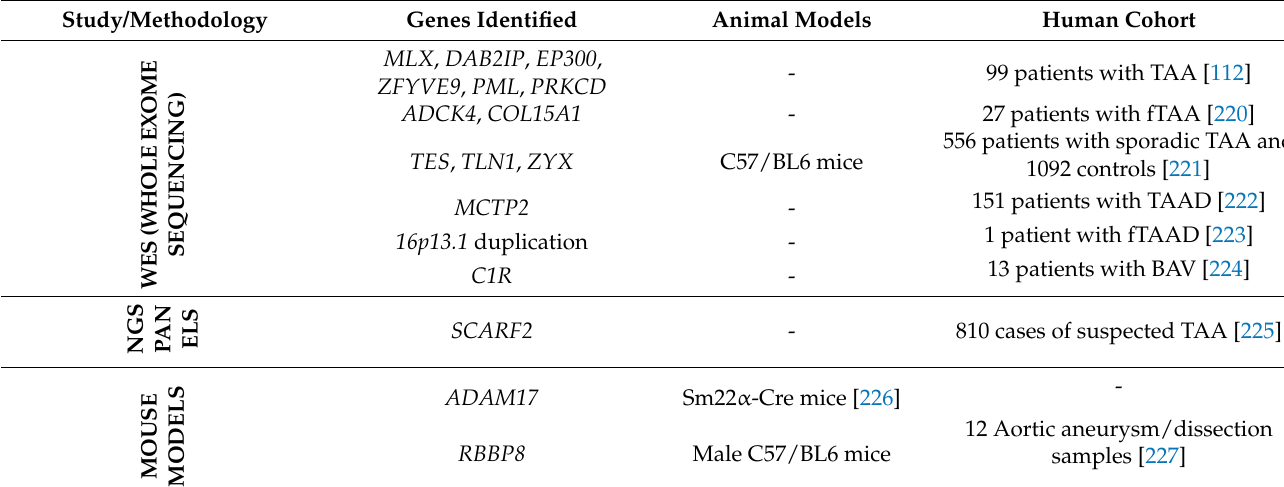
Table 4. Novel potential TAAD-associated genes.